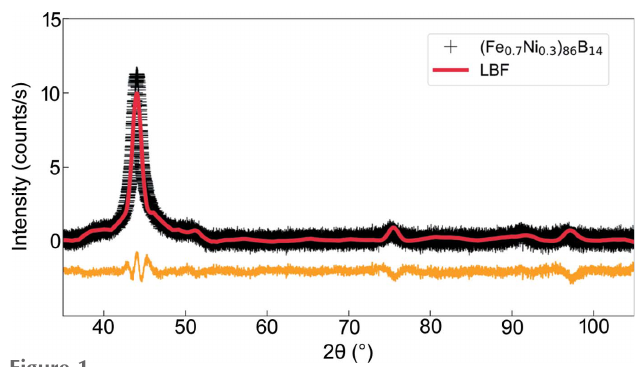
Figure 1 XRD pattern for (Fe 0.7 Ni 0.3 ) 86 B 14 ribbons, a HiB-NANOPERM-type soft magnetic nanocrystalline material (black crosses; Cu K (cid:2) radiation). Red solid line: XRD data refinement using the LBF method implemented in the FullProf software. The bottom orange solid line represents the difference between the calculated and experimental intensities.